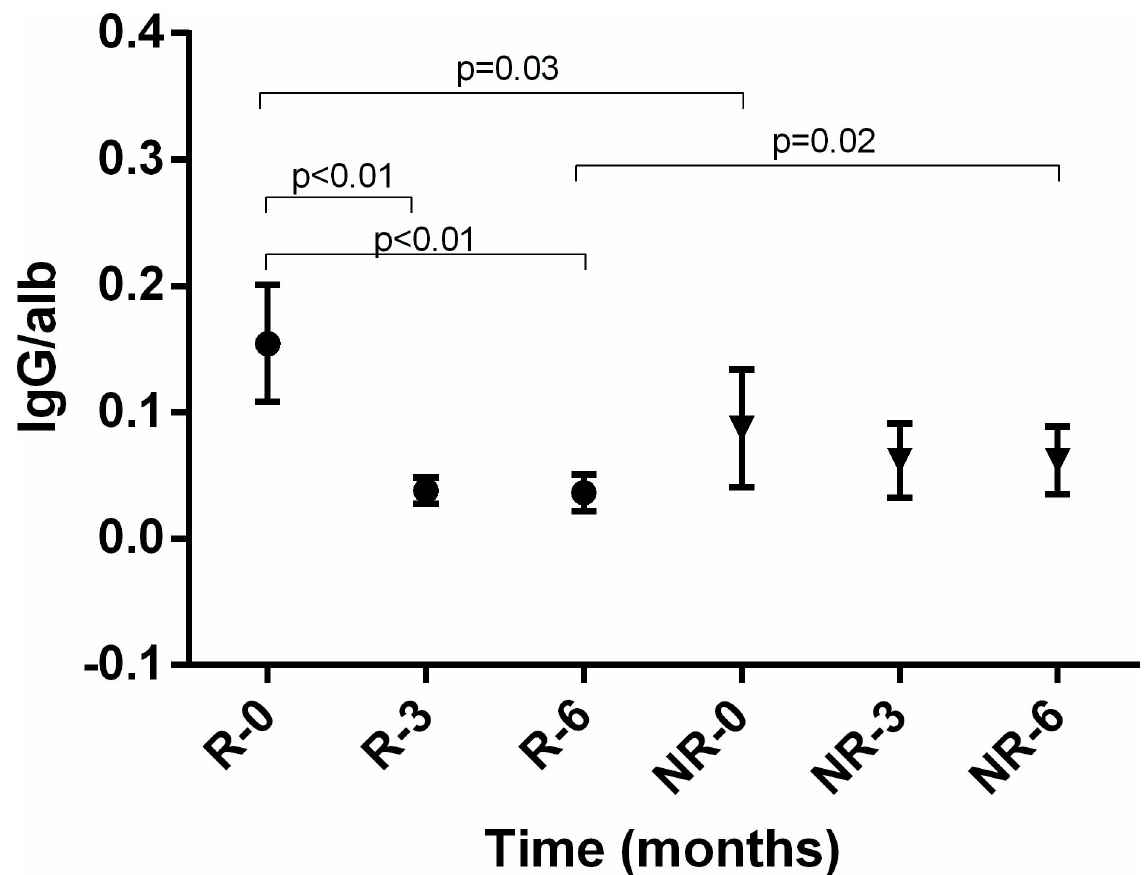
Figure 2. Mean urine IgG to albumin ratio in responders (R) and non-responders (NR) in time. doi: